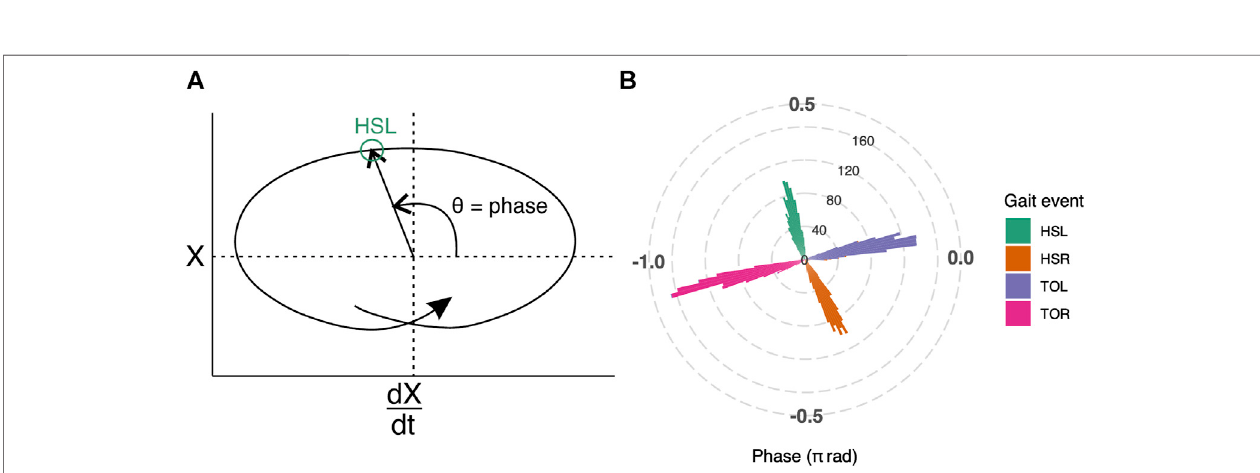
FIGURE 2| (A) Illustration ofhow gait phase wasdetermined. Mediolateral COP displacement data are represented in the phase plane. The horizontalaxis, dX/dt, is the fi rst derivative of COPX with respect to time; the vertical axis, labeled as X, is the COP in the mediolateral direction. The origin is set at the average value over the entire trial. Polar coordinates ( θ ) derived from the phase plane, were used to determine the gait phase (see Supplementary Figure S2 for plot with real gait events). (B) Gaitphasewasvalidatedagainstgaiteventsthatwereindependentlydetectedbythetreadmillmanufacturer ’ ssoftwareforalltrials.Thephaseofthegaiteventsare represented as a polar histogram, where left heel-strike (HSL, green) occurs approximately at 0.59 π radians, right toe-off (TOR, pink) at -0.90 π radians, right heel-strike (HSR, orange) at -0.34 π radians, and left toe-off (TOL, purple) at 0.06 π radians.